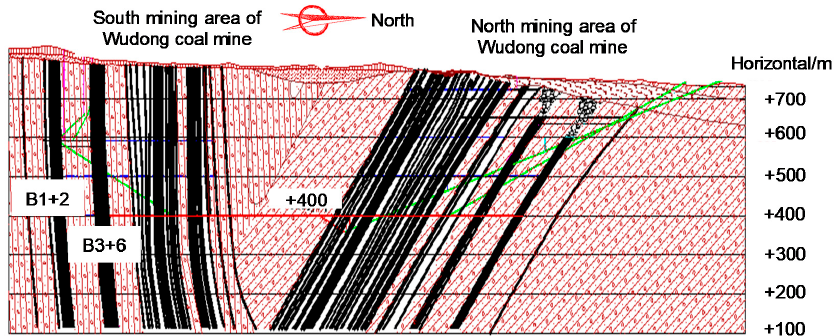
Figure 4. Geologic section of WCM.